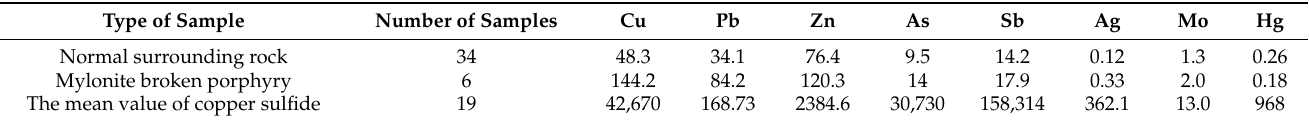
Table 1. Comparison of element content in surrounding rocks, tectonic rocks, and copper minerals in the Jinman deposit (ppm).